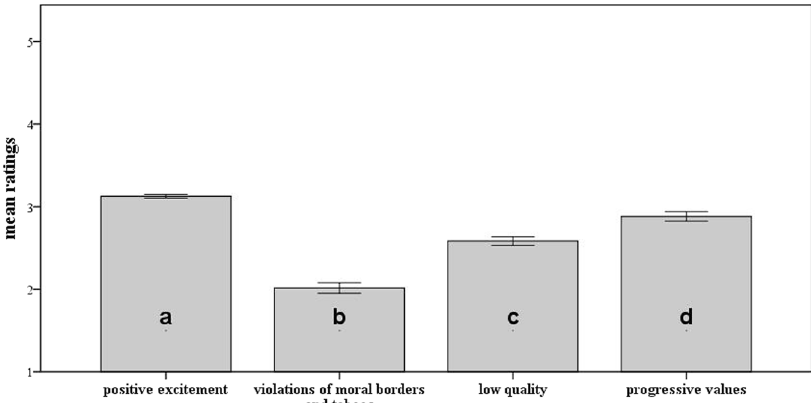
Fig. 2 Mean ratings for each of the four components re fl ecting participants ’ opinions about erotic novels. Error bars indicate the standard error of the mean. Means with different letters are signi fi cantly different.